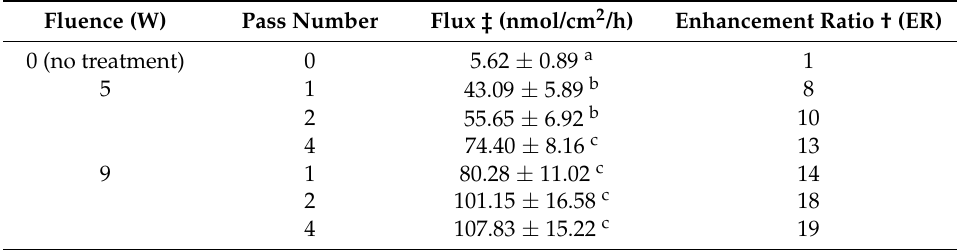
Table 1. MAP-1 normalized fluxes across porcine skin after pretreatment with a fractional CO 2 laser ( n = 8 for each fluency condition).